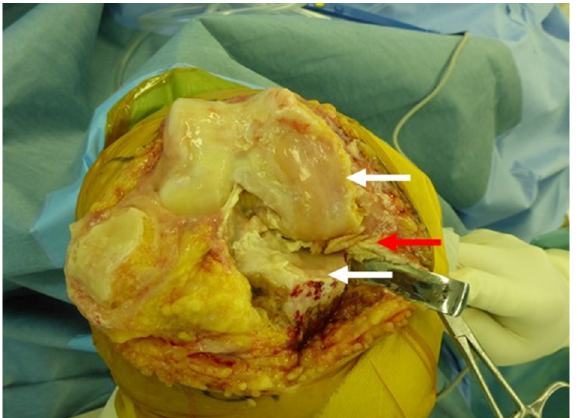
Figure 2. Right knee joint removed during Subject’s surgery. The white arrows indicate that the cartilage on the medial femoral joint surface and tibial joint surface was completely destroyed and bone was exposed. The red arrow points to the degenerated and torn medial meniscus.